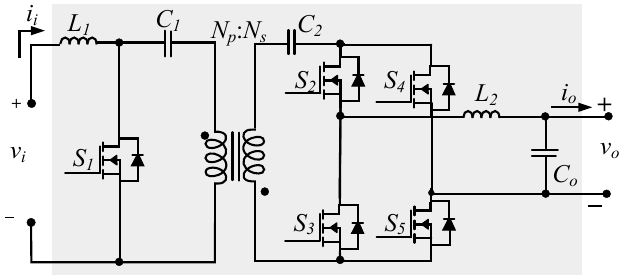
Figure 8. Cuk-based SM.